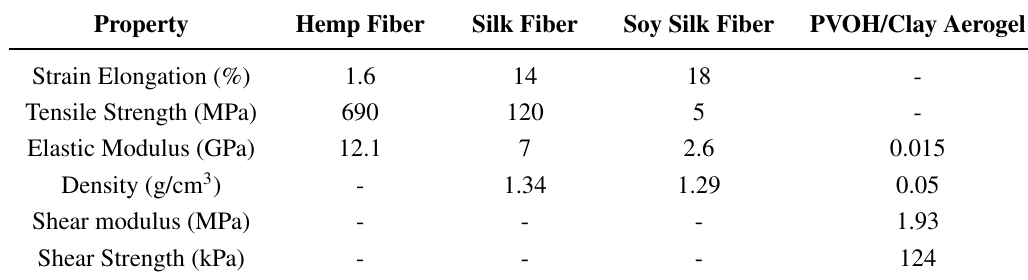
Table 7. Properties of hemp, silk, and soy silk fiber, and poly(vinyl alcohol) (PVOH)/clay aerogel. The shear modulus and shear strength were taken to be equal to those of expanded polystyrene with the same